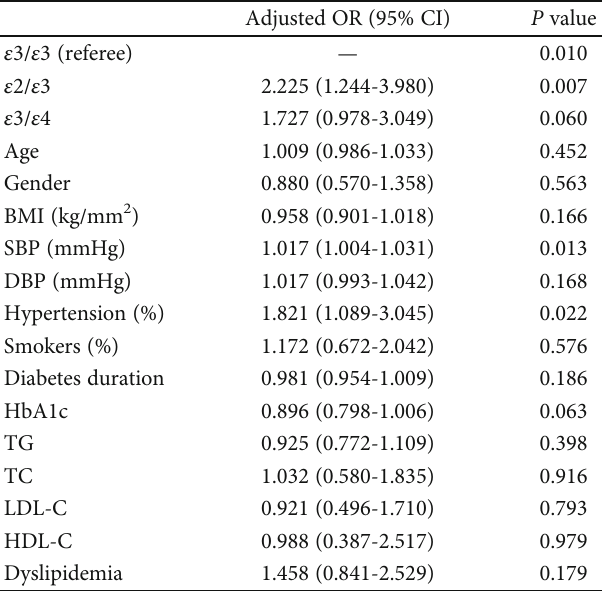
The extremely rare genotypes — ε 2/ ε 2, ε 2/ ε 4, and ε 4/ ε 4 subjects — were excluded from statistical analysis. Table 4: Associations of APOE gene polymorphisms and the risk of IS in T2DM patients compared to that in case patients, represented as adjusted